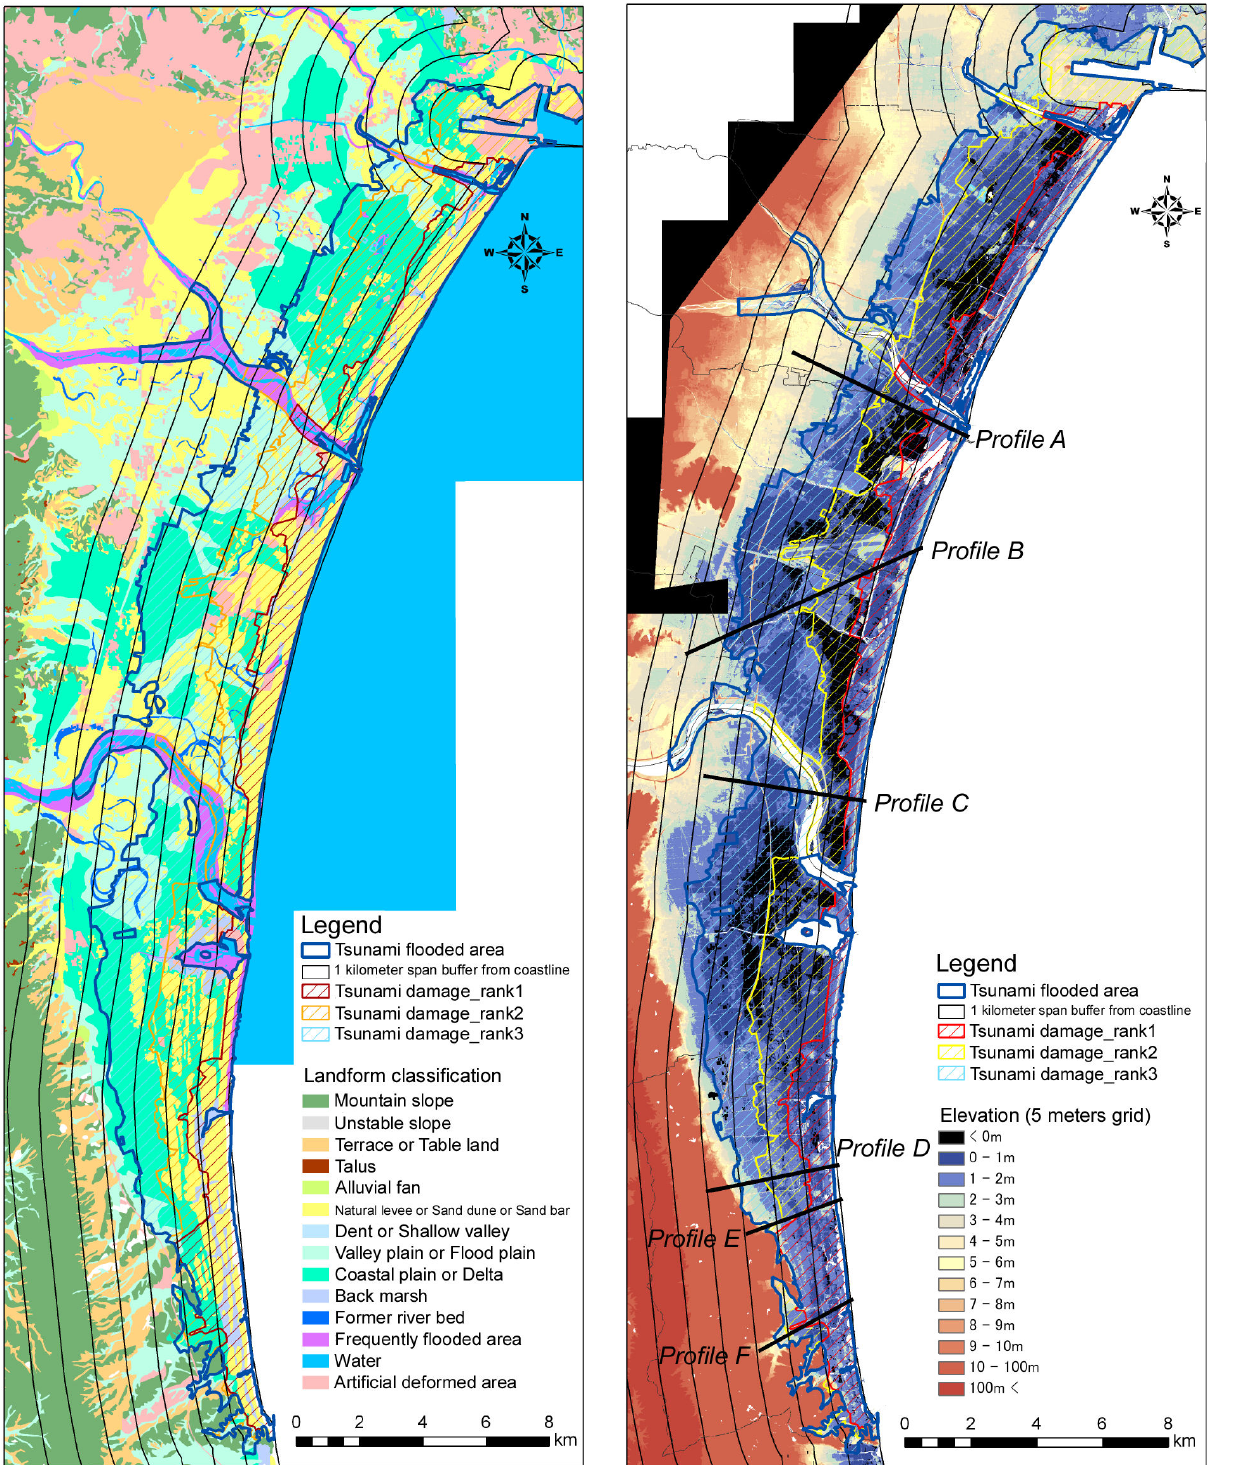
Figure 8. Overlay of tsunami damage and LiDAR